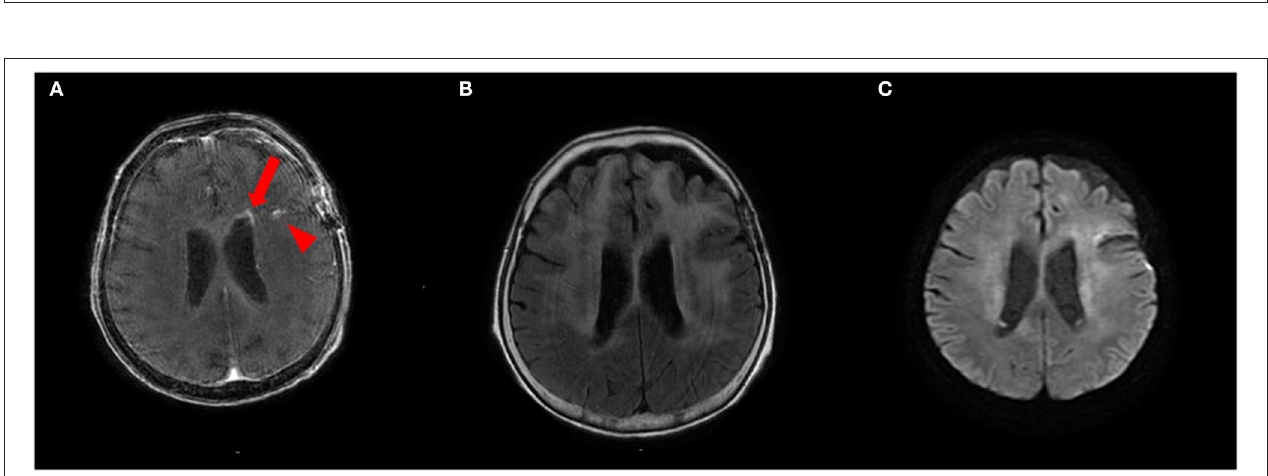
FIGURE 3 | Pathological findings. Brain biopsy from the left frontal lobe. (A) Hematoxylin and eosin staining. (B) CD20 immunohistochemical staining. (C) Ki-67 immunohistochemical staining. (D) CD3 immunohistochemical staining.